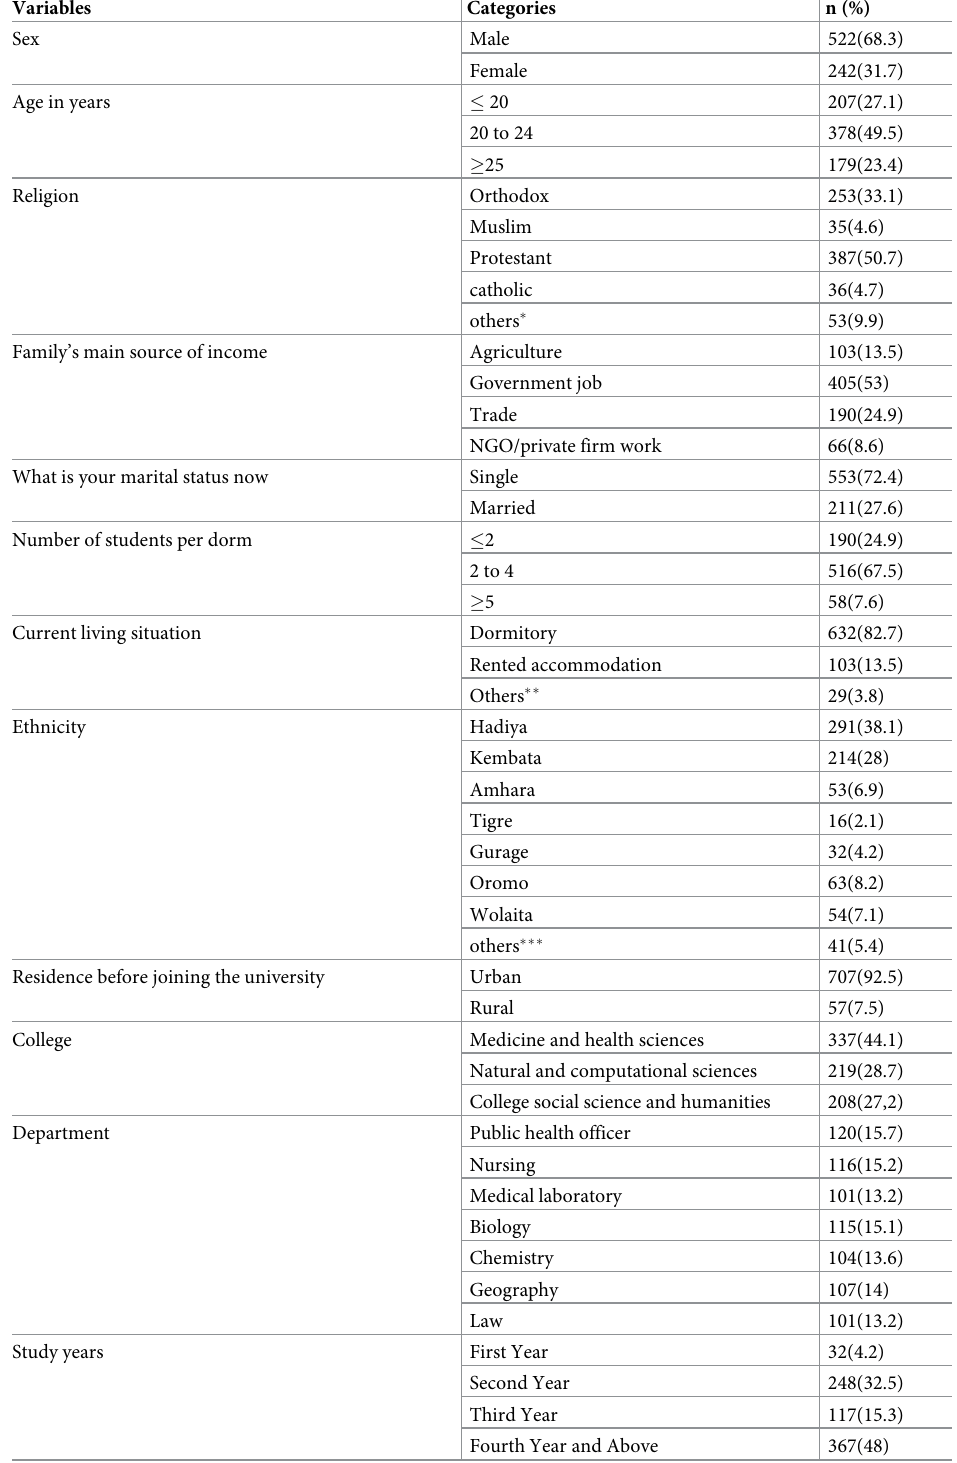
Table 1. Sociodemographic characteristics of the respondents on knowledge, attitudes, and practices of face mask utilization and associated factors in COVID-19 pandemic among Wachemo university students, southern Ethio- pia: February to March 2021 (n =